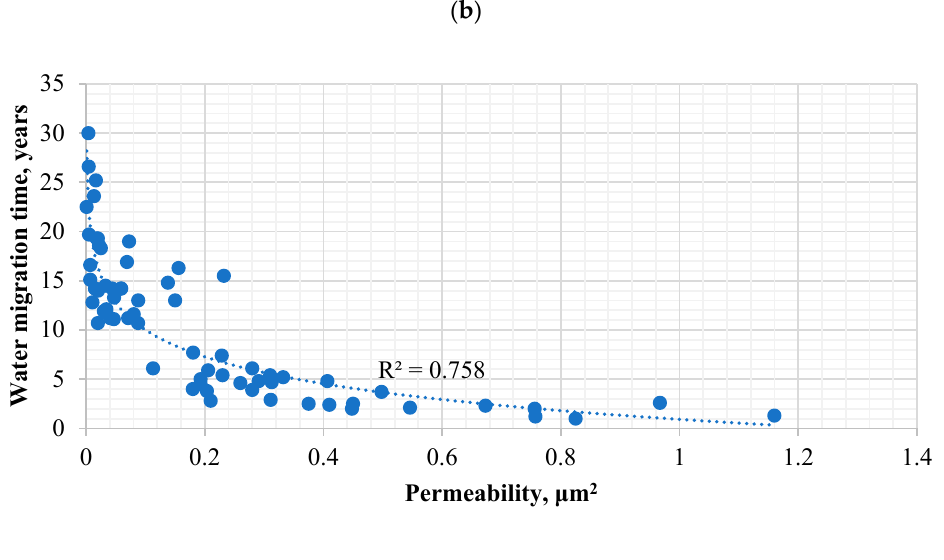
Figure 6. Dependence of the water migration time on the permeability: ( a ) all wells, ( b ) P inj − P bot < 10 MPa, and ( c ) P inj − P bot > 10